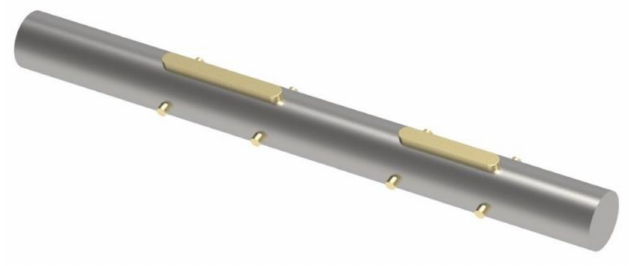
Figure 16. Shaft subassembly with cotter and dowel pins.